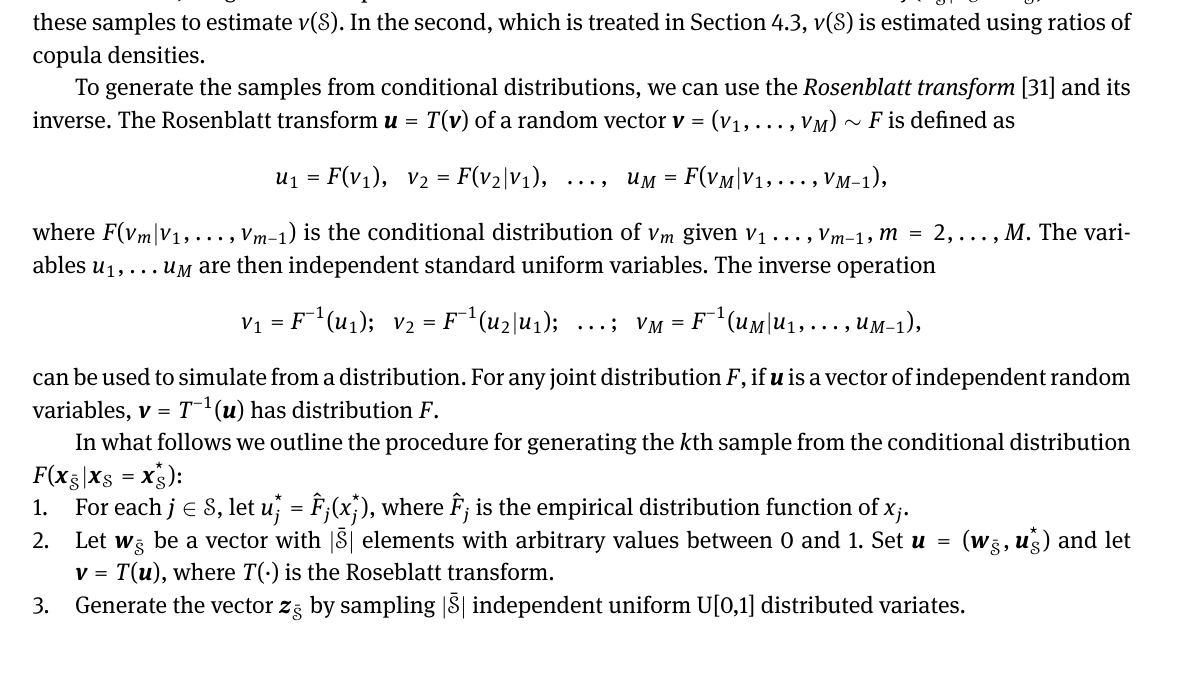
, . . . , x except through the conditional marginal j +1 j + i −1